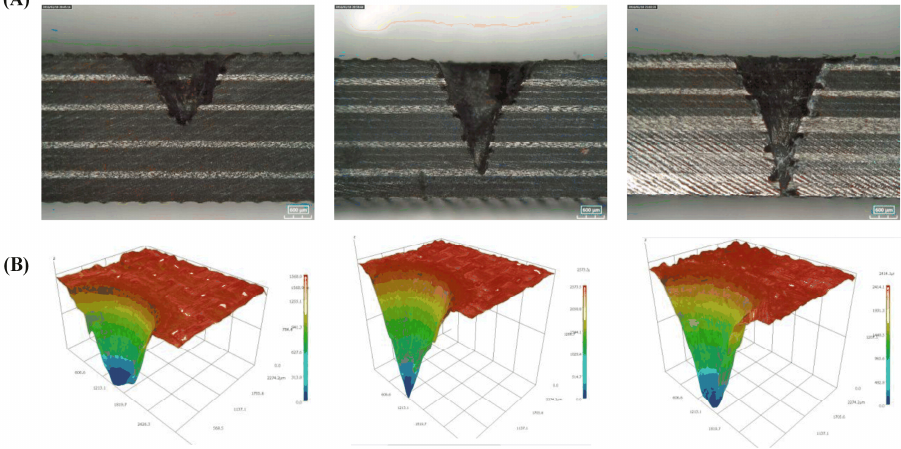
Figure 20. Phenomenon and simulation experiment diagram of processing time of 6, 8, and 10 s in CFRP laser drilling: ( A ) experiment; ( B ) simulation [141].